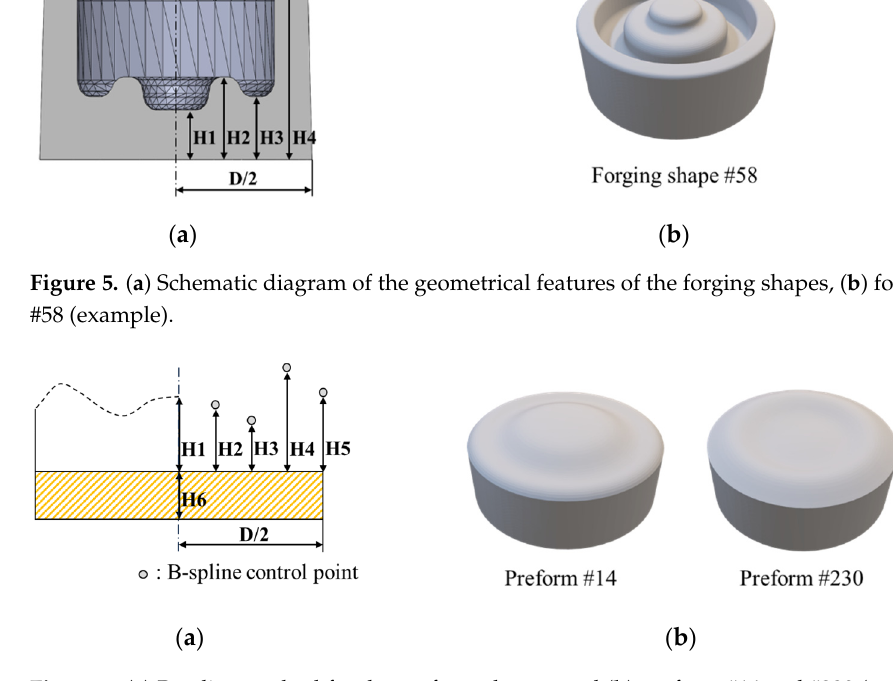
Figure 6. ( a ) B-spline method for the preform shapes, and ( b ) preform #14 and #230 (examples).